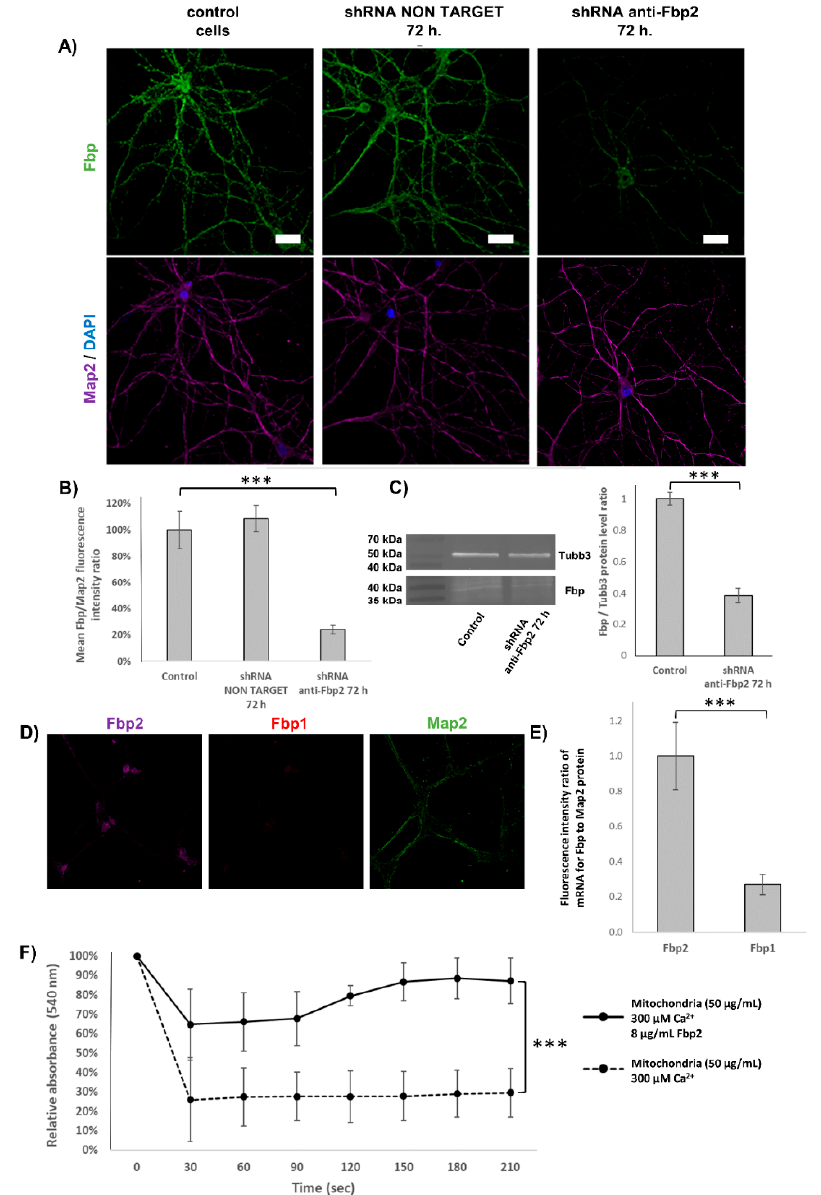
Figure 1. ( A – C ) Silencing of fructose 1,6-bisphosphatase 2 (Fbp2) expression in cultured hippocampal neurons. ( A ) Expression of Fbp in hippocampal neurons: untreated (left image), treated with antisense shRNA (middle image) and shRNA against Fbp2 (right image). Bar = 20 µ m, N = 30 regions of interest (ROIs). ( B ) Decrease in Fbp2-associated fluorescence (expressed as the ratio of Fbp2 to Map2 fluorescence). ( C ) Western blot analysis of Fbp2-silenced hippocampal neurons and densitometric analysis of the protein level. Tubulin β 3 was used as a reference protein. ( D , E ) Fbp2 is the main isoform of Fbp in hippocampal neurons. ( D ) In situ hybridization demonstrates that fluorescent signal associated with mRNA for Fbp2 is much stronger than for Fbp1. ( E ) Quantification of the mRNA for Fbp2 and Fbp1. Bar = 20 µ m, N = 30 ROIs. ( F ) Fbp2 protects neuronal mitochondria against calcium-induced swelling. The amount of swollen mitochondria is inversely proportional to the decrease of relative absorbance at 540 nm. The absorbance measured before Ca 2 + addition was assumed to be 100%. The values are given as a mean and SD. *** indicates p <